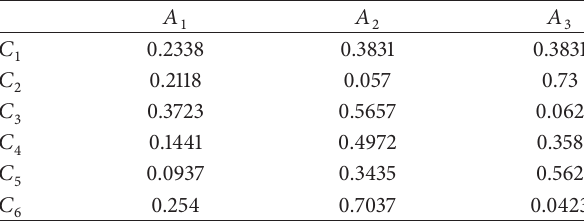
Table 12: Final weight of criteria by using TODIM.